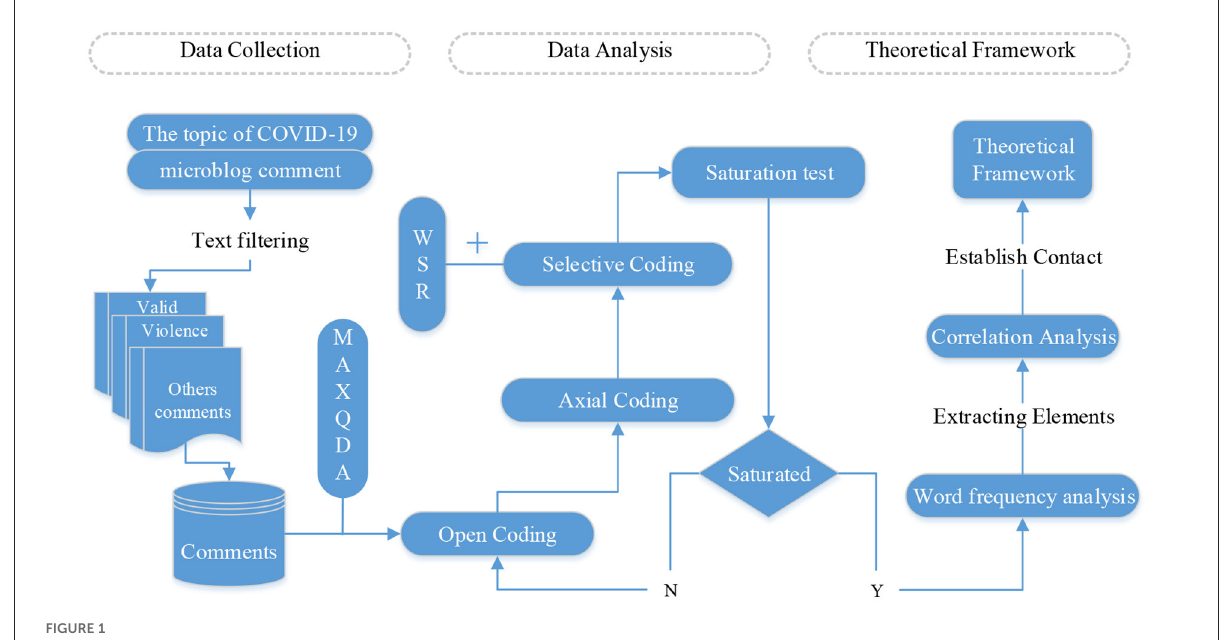
FIGURE1 Method flowchart.